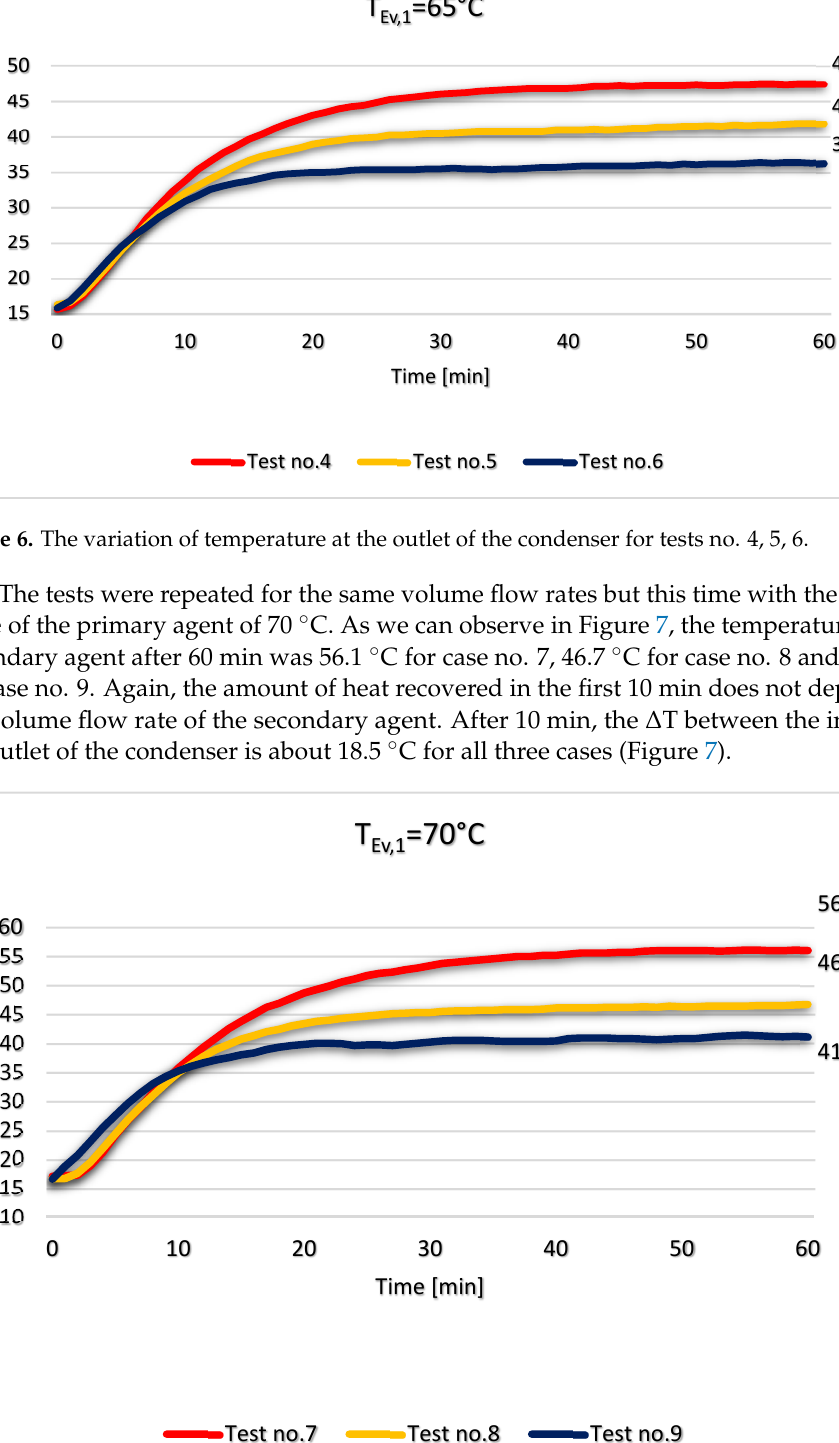
Figure 7. The variation of temperature at the outlet of the condenser for tests no. 7, 8, 9.